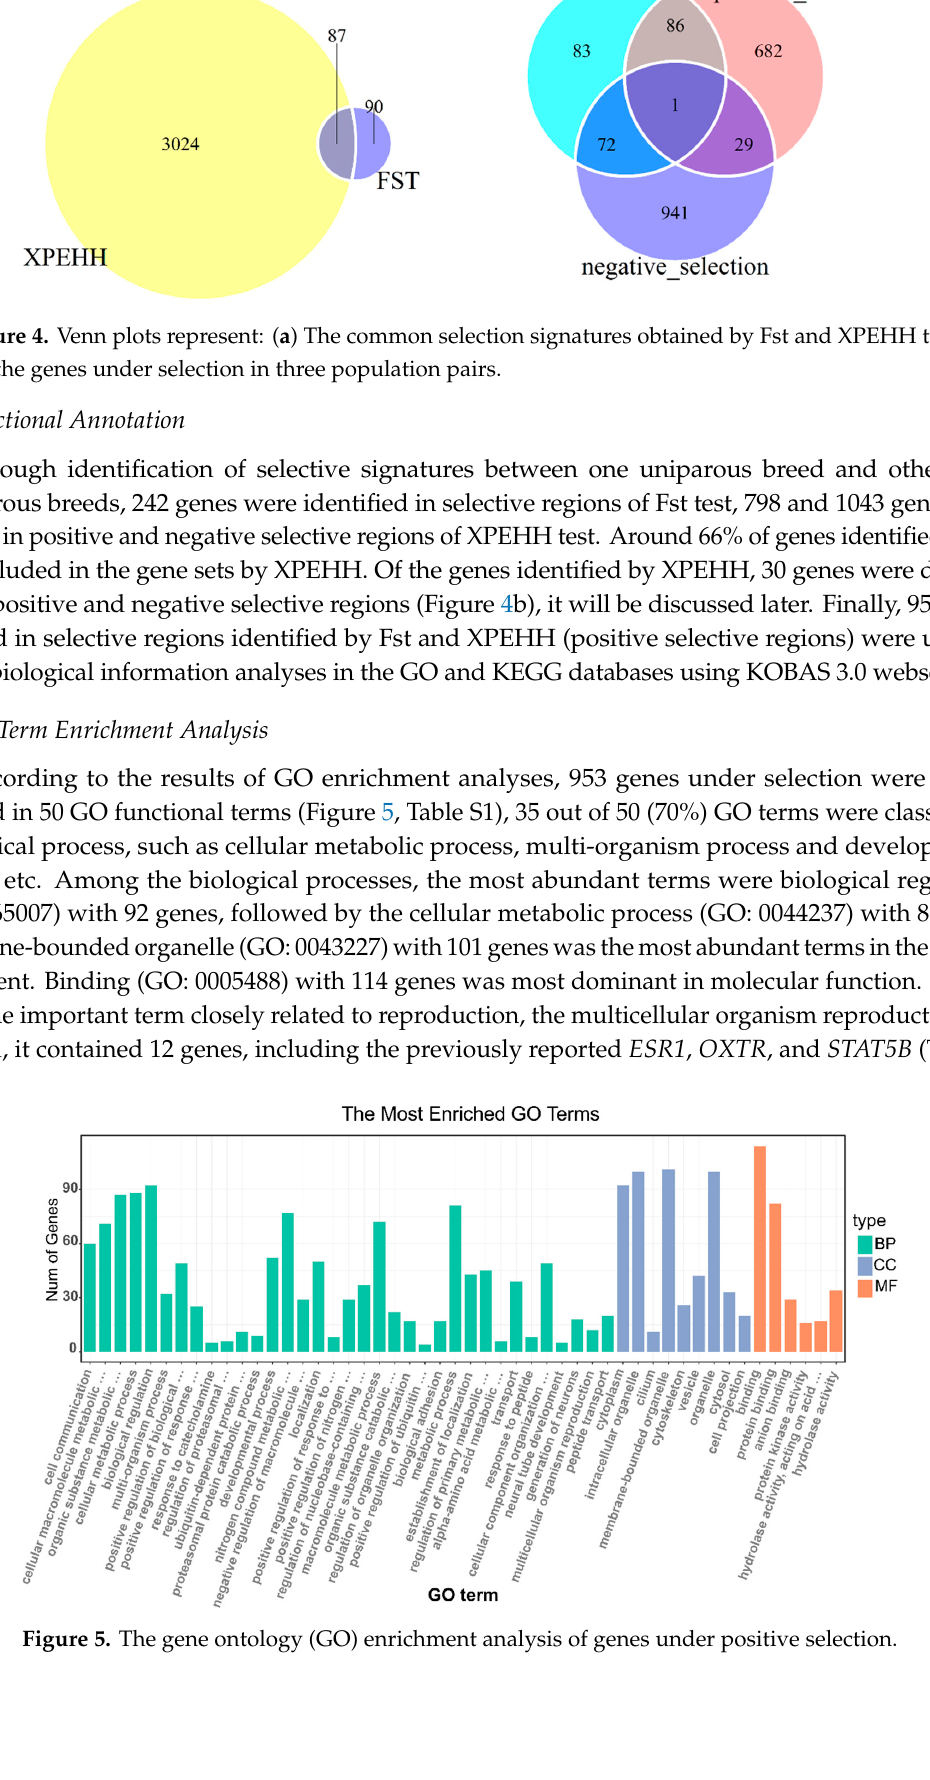
signatures (red) and negative selection (blue).